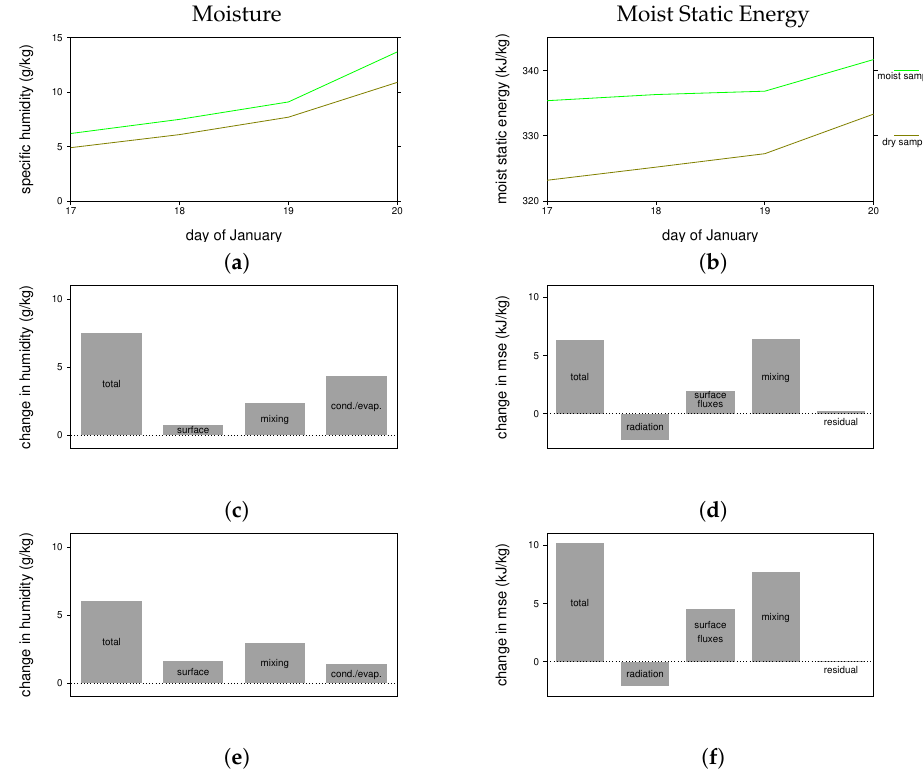
Figure 9. Moisture and moist static energy budgets for the mean parcel trajectories shown in Figure 8. ( a , b ) evolution of moisture and moist static energy for parcels entering the moist (green) and dry (gold) regions, respectively; ( c , d ) contributions to changes in moisture and moist static energy for the moist sample from surface fluxes, radiation, mixing with convective updrafts, and/or evaporation/condensation of hydrometeors; ( e , f ) contributions to changes in moisture and moist static energy for the dry sample from surface fluxes, radiation, mixing with convective updrafts, and/or evaporation/condensation of